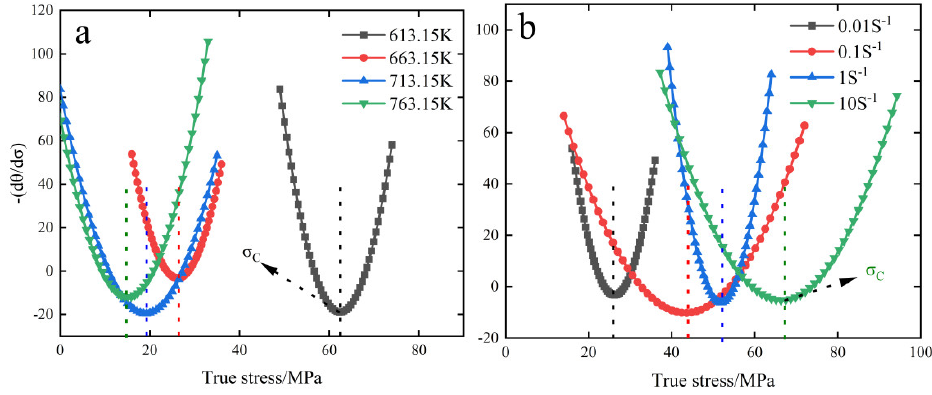
Figure 7. ( − d θ / d σ ) − σ curves for different creep conditions: ( a ) 0.01 S − 1 , ( b ) 663.15 K. From the change of curves in Figure 7, it can be seen that the increase in temperature and the decrease in strain rate will lead to the subsequent decrease of critical stress; the increase of temperature will enhance the rate of atomic motion inside the material, which is prone to interatomic dislocation slip and promote DRX nucleation, thus decreasing the creep dynamic recrystallization critical condition; the decrease of strain rate is less likely to lead to a large number of dislocation entanglement, and the stress generated by